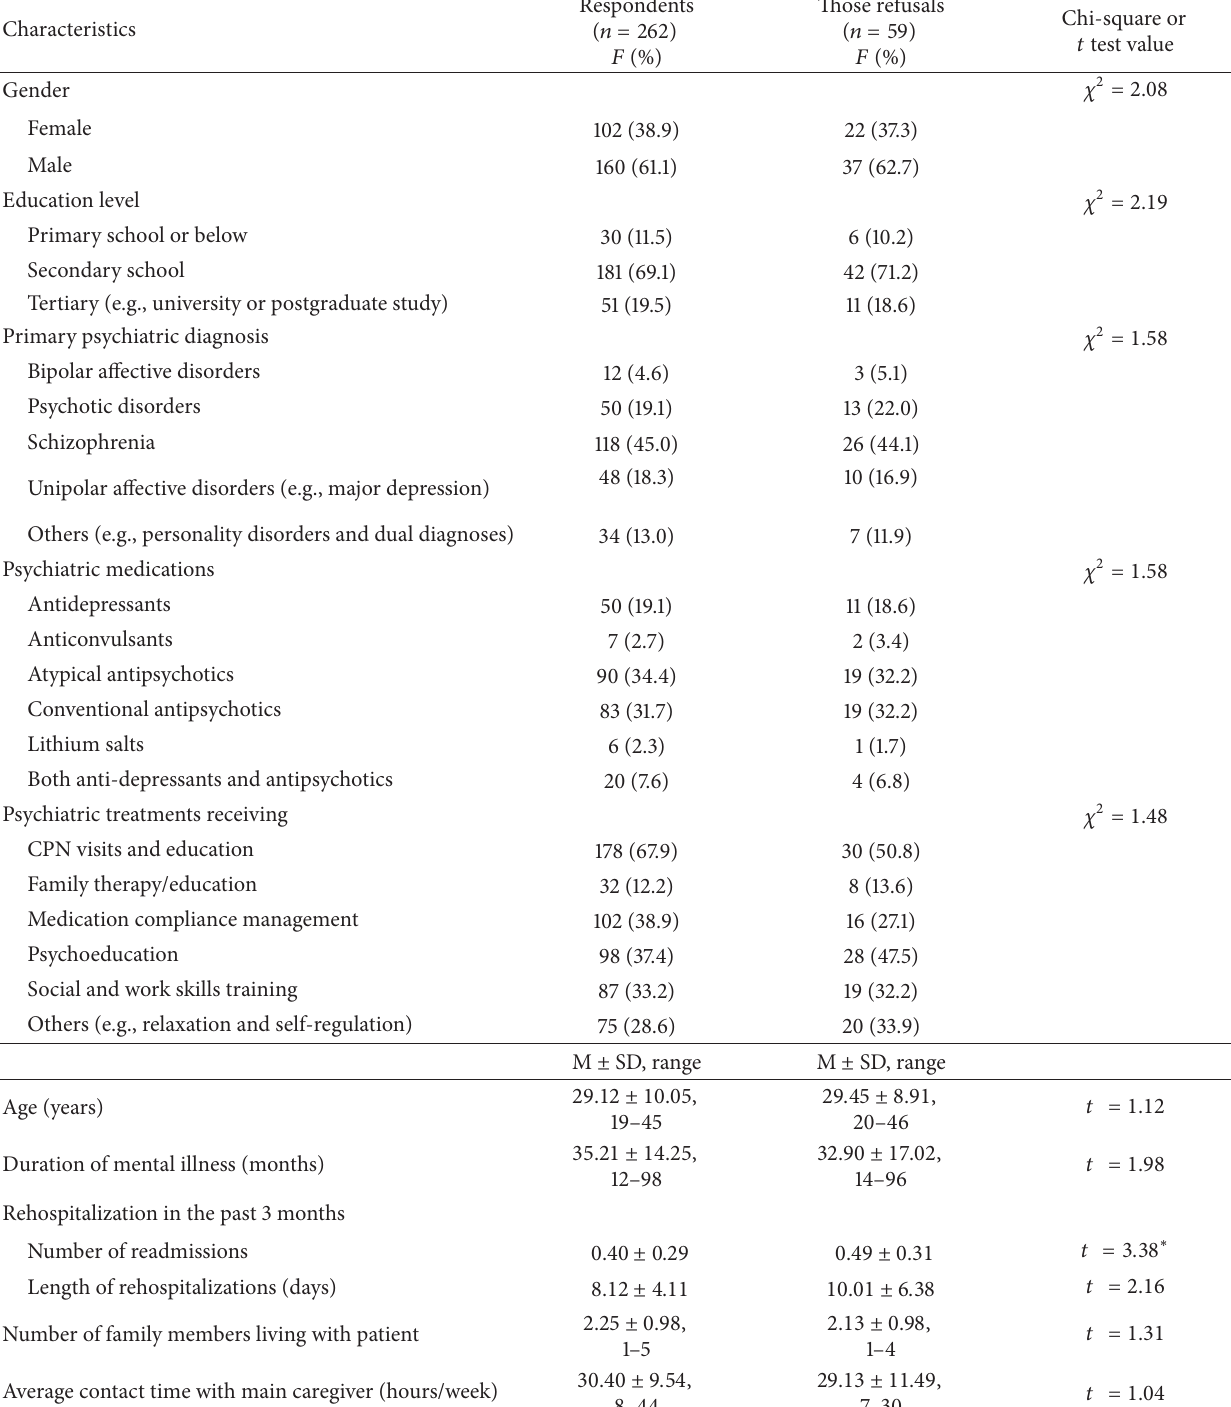
Table 1: Characteristics of patients with severe mental illness and